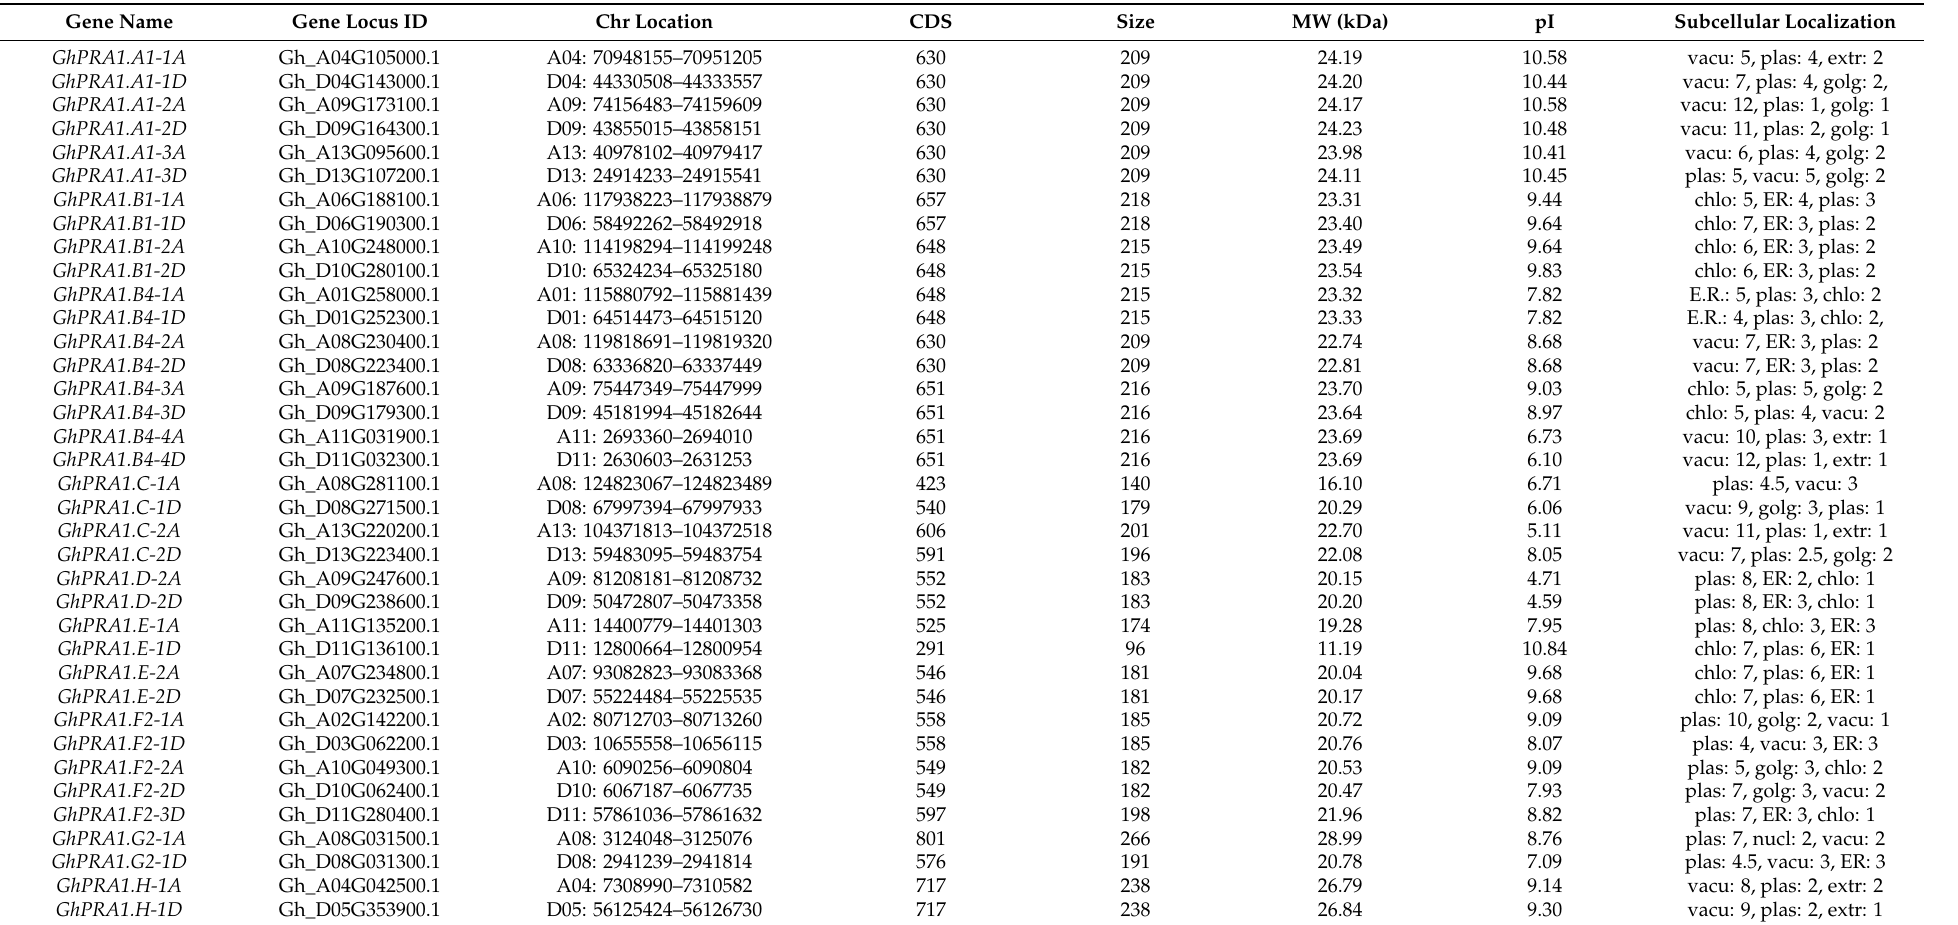
Table 1. Identification of the GhPRA1 genes. Abbreviations: vacu, vacuole; plas, plasmalemma; golg, Golgi; chlo, chloroplast; ER, endoplasmic; extr,